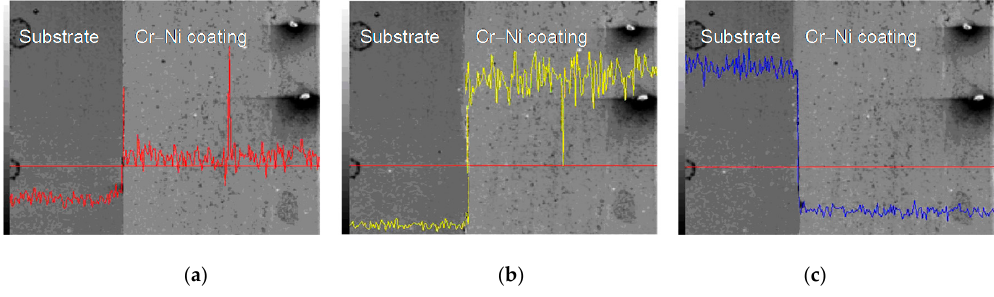
Figure 7. Line scan analysis of 20% Cr–80% Ni coating interface. ( a ) Line scan analysis of Cr content; ( b ) Line scan analysis of Ni content; ( c ) Line scan analysis of Fe content.